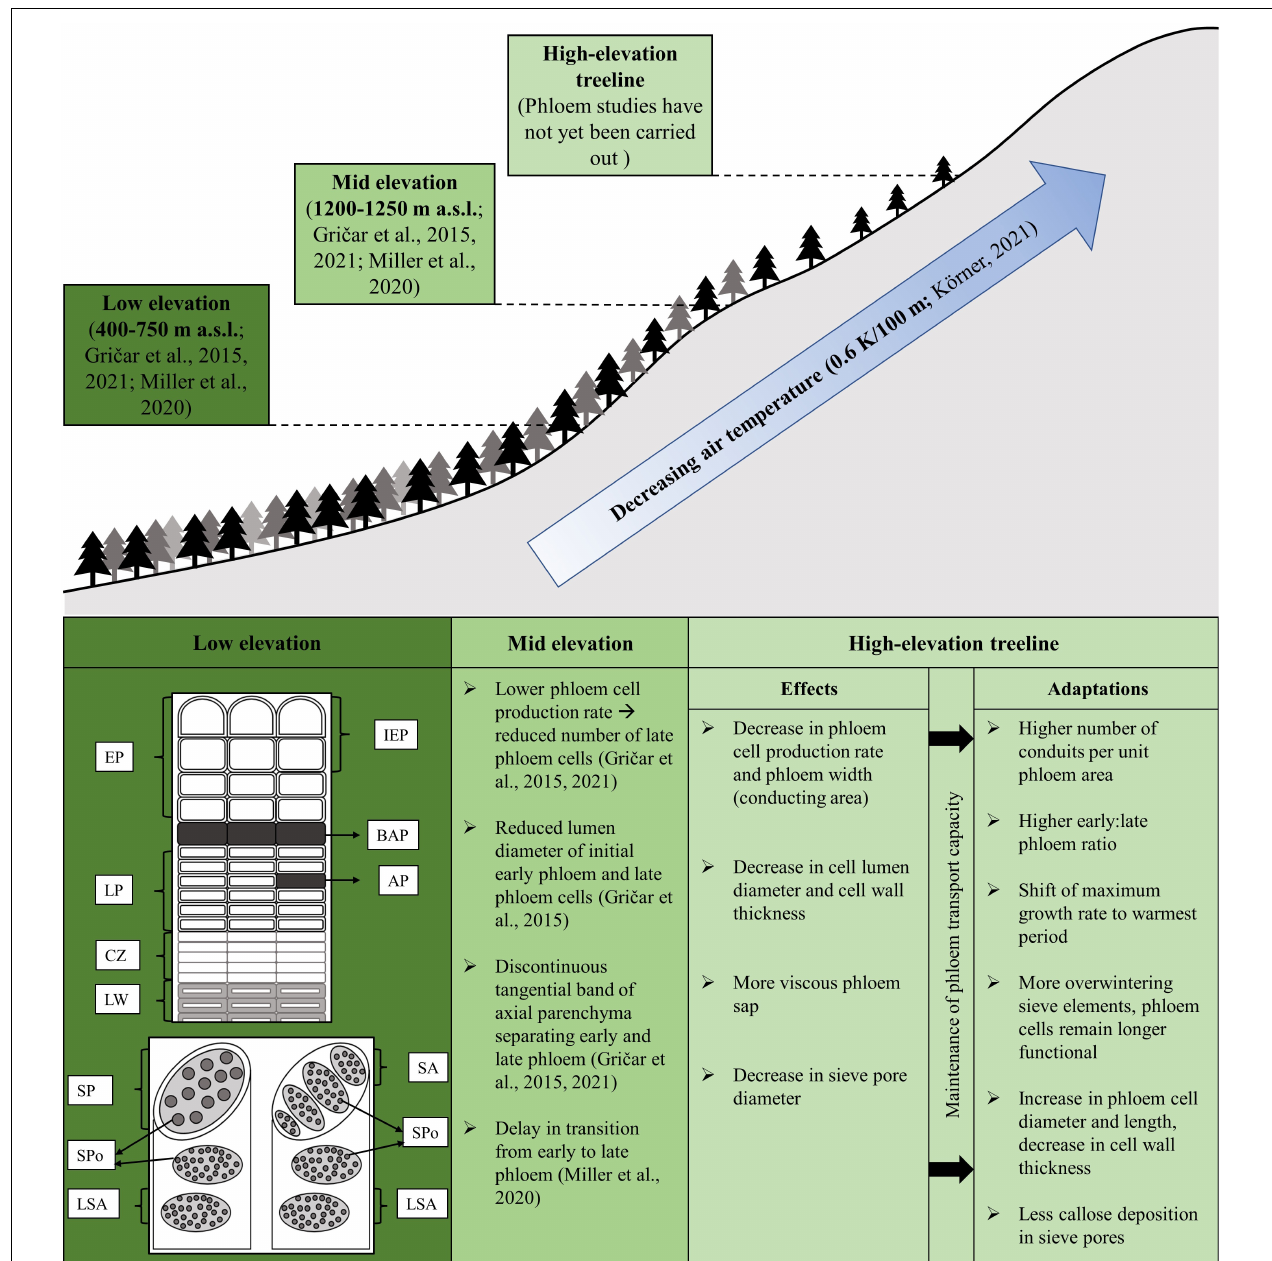
FIGURE 1 | Schematic illustration of known and assumed low-temperature effects on phloem anatomy and formation along an elevational transect. Upper graphic: Current studies dealing with environmental influence on the phloem conducted at different elevations. Below: General phloem structure at low-elevation sites, alterations caused by decrease in temperature at mid-elevation sites, and effects and possible phloem adaptations at the high-elevation treeline. Low elevation, top: Annual phloem ring exemplified by Picea abies after Griˇcar and ˇCufar (2008) consist of early phloem (EP) with initial early phloem (IEP), the continuous tangential band (BAP) of axial parenchyma cells (AP), late phloem (LP) with adjacent cambial zone (CZ) and latewood tracheids (LW); bottom: phloem cells (axial view) with lateral sieve areas (LSA) and sieve pores (SPo), as well as axial sieve areas (SA) in conifers (right) and sieve plates (SP) with larger sieve pores in angiosperms (left),